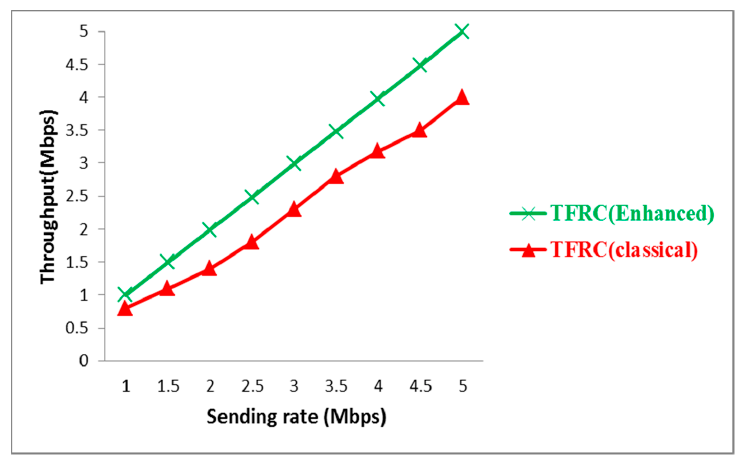
Figure 3. Throughput comparison of classical TFRC and enhanced TFRC.